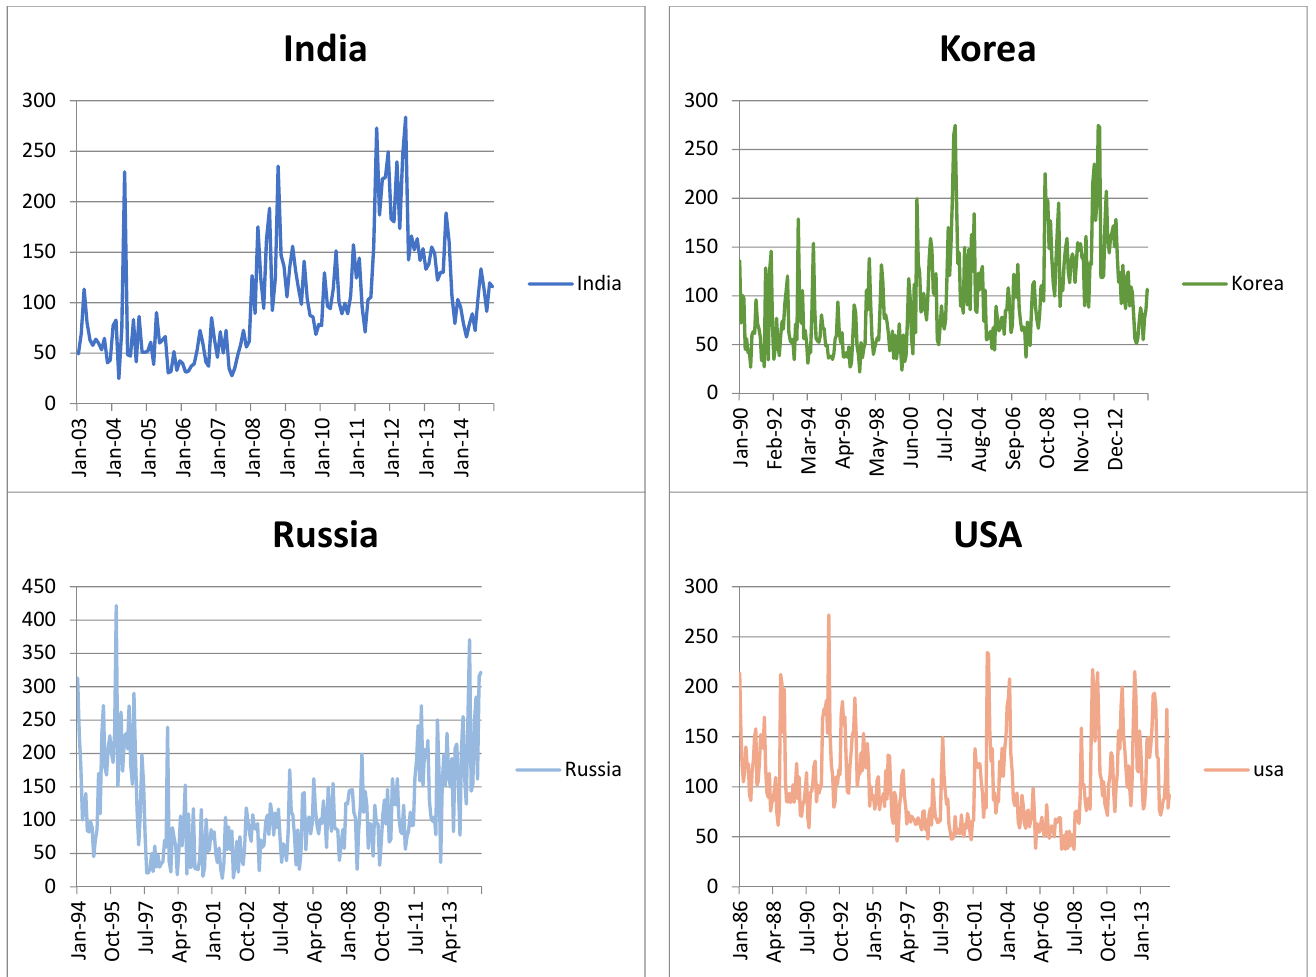
Figure 2. Plot of Policy Uncertainty Measure in Each Country.